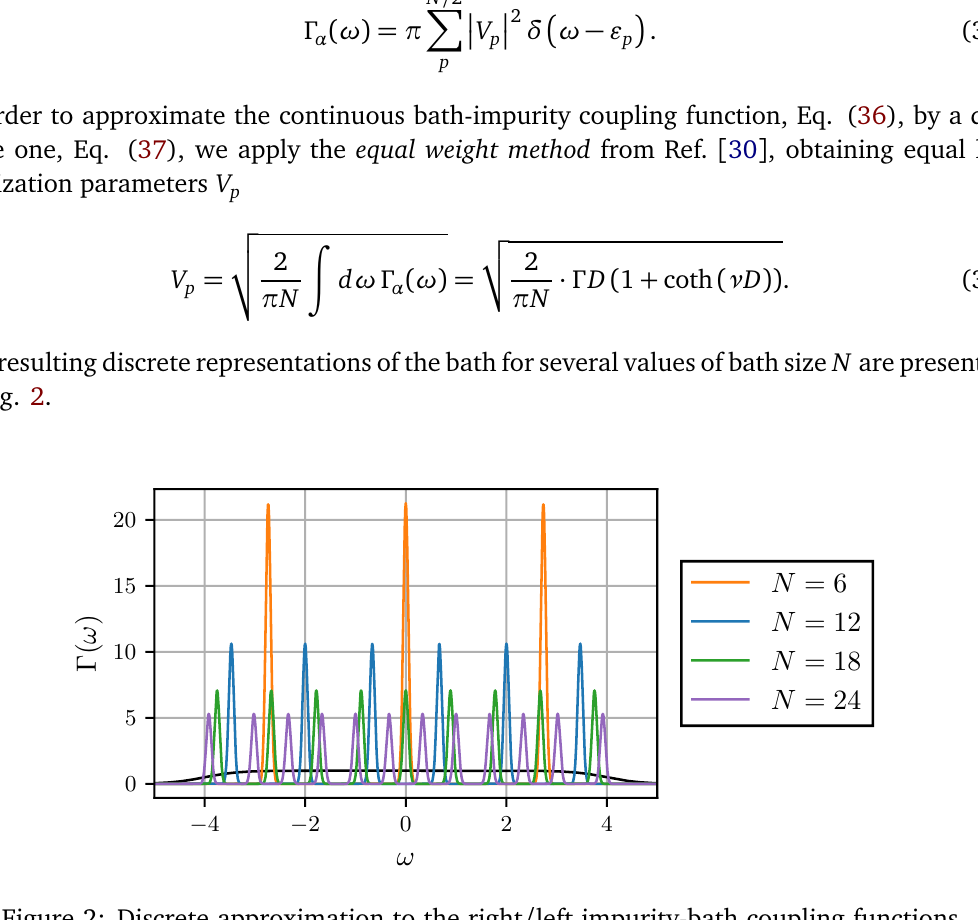
Figure 2: Discrete approximation to the right / left impurity-bath coupling functions Γ ( ω ) = Γ ( ω ) for different (total) numbers of bath sites N (a Gaussian broadening α of width 0.1 was used for the purpose of the picture). The solid black line is the continuous coupling function from Eq.